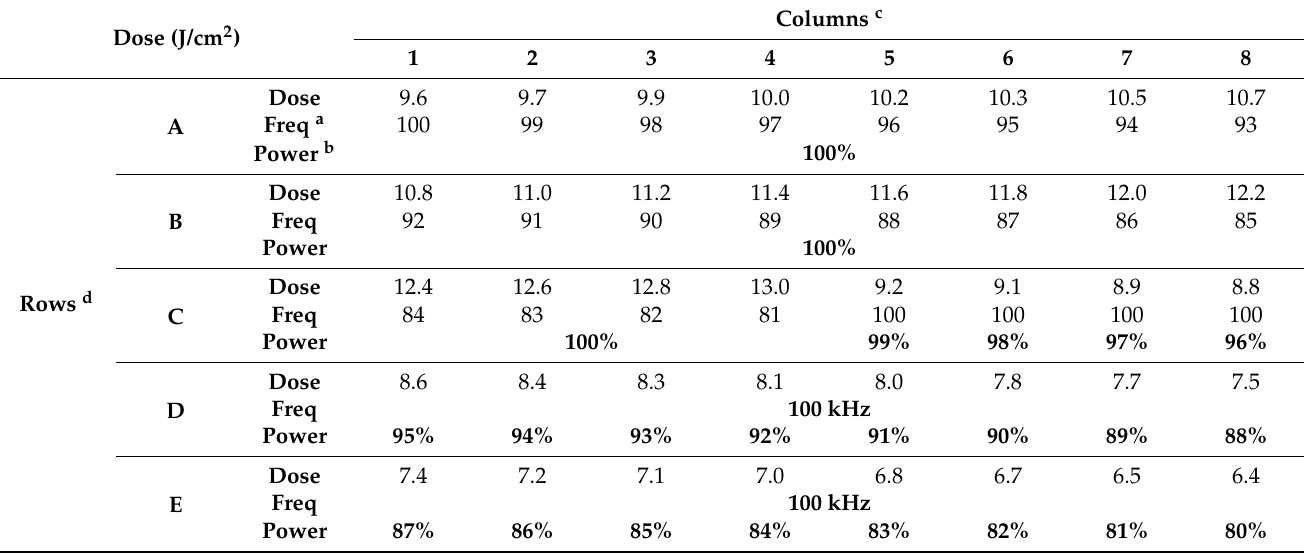
Table 3. Summary of the laser parameters used to obtain red areas during direct laser writing process. Dose (J/cm 2 )